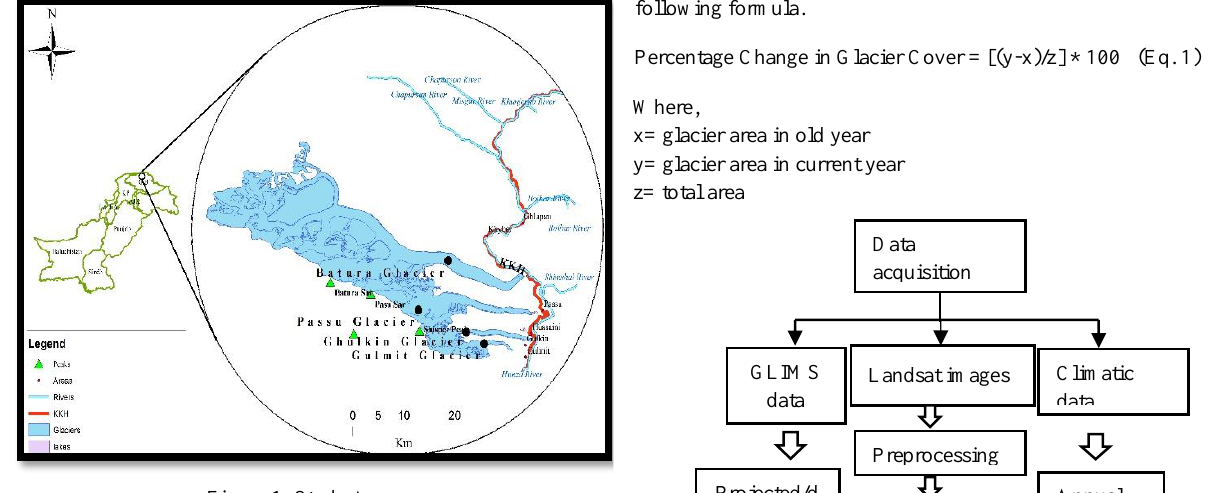
Figure 1: Study Area